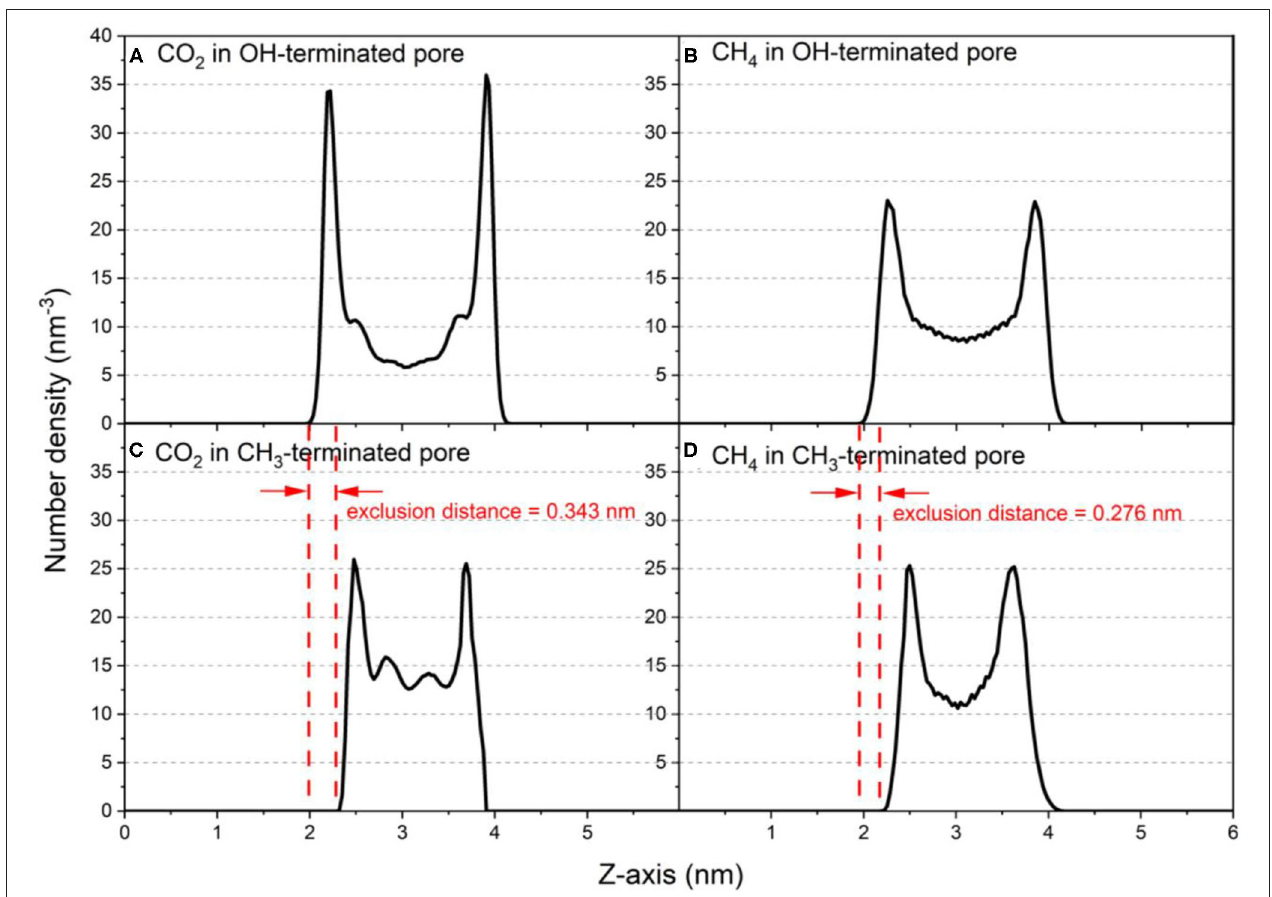
FIGURE 2 | Number density profiles of confined CO 2 and CH 4 molecules along the vector normal to the pore surface (z-axis) in (A,B) OH-terminated pores and (C,D) CH 3 -terminated pores in pore diameter of 2nm. The density profiles are averaged over the last 10 ns of the simulation